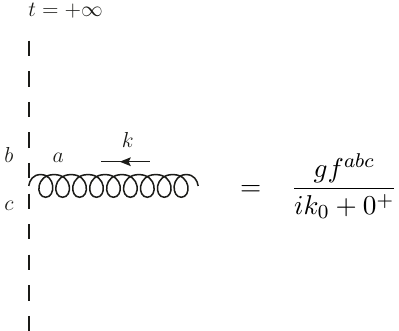
Figure 4. Feynman rule associated with gauge boson insertions of Wilson lines. The color index b is to be contracted with the next operator along the Wilson line towards t = + ∞ , while the index c is contracted with the next operator in the direction towards the electric field insertion, which is at the lower end of the vertical dashed line and not shown here